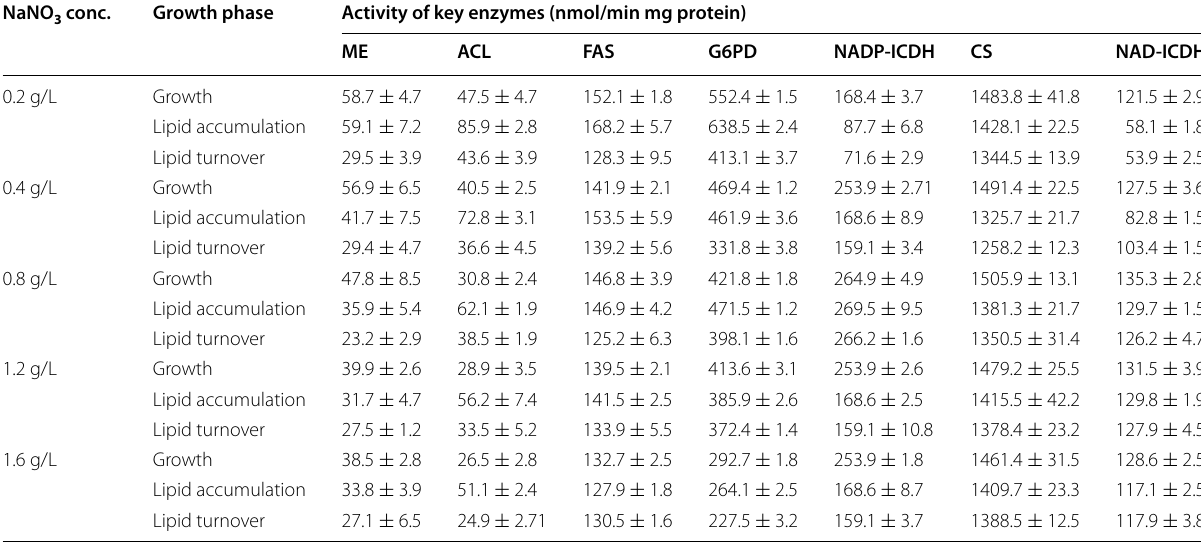
All experiments were performed in triplicate. The data presented here is mean G6PD glucose-6-phosphate dehydrogenase, CS citrate synthase, NAD + -ICDH NAD dependent isocitrate dehydrogenase, NADP + -ICDH NADP dependent isocitrate dehydrogenase, ACL ATP-citrate lyase, ME malic enzyme, FAS fatty acid synthase